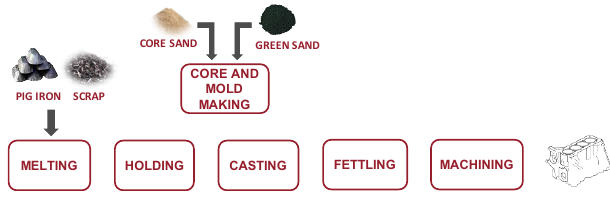
Figure 6. Process flow for cast iron (CI) engine block manufacturing.